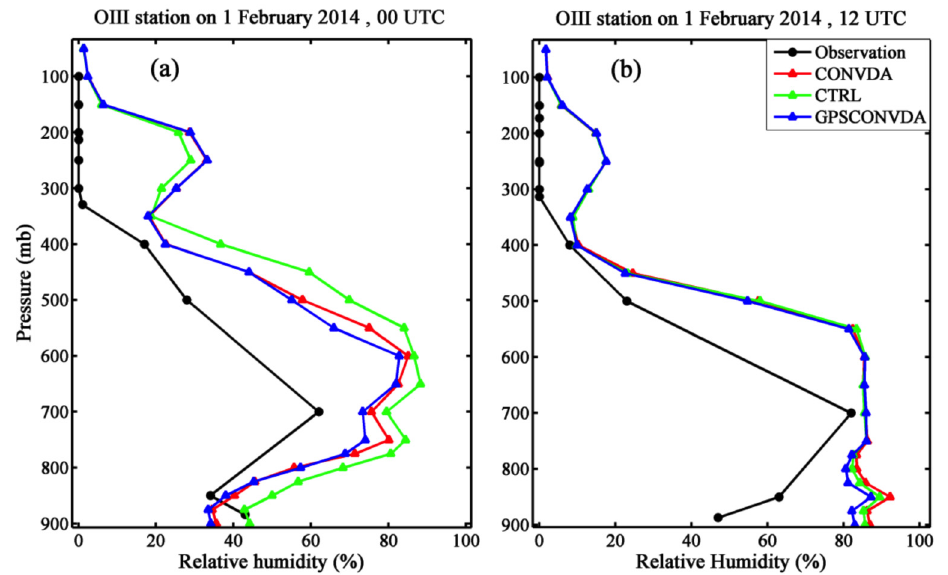
Figure 4. Comparison of the WRF predicted vertical profiles of relative humidity (%) from different experiments with radiosonde obser- vations at Tehran Mehrabad airport (OIII: latitude=35.68°N, longitude=51.35°E) in (a) 12h and (b) 24h simulation. The WRF start the pre- diction on January 31, 2014, 12